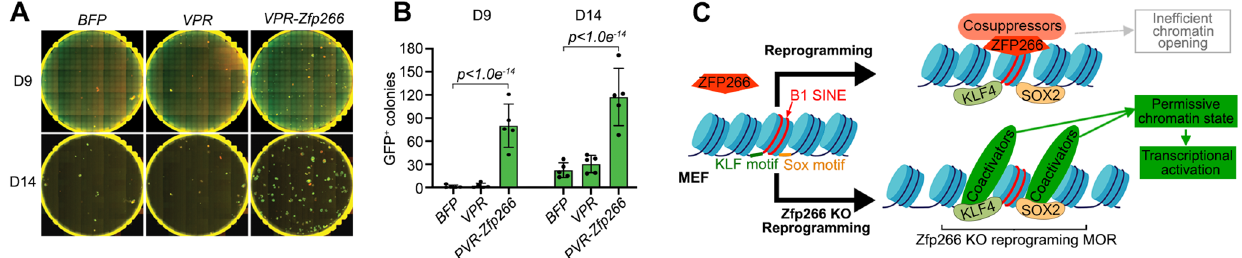
Fig. 7 | Chromatin accessibility at the ZFP266 target loci affects reprogram- ming ef fi ciency. A Day 9 and day 14 after OSKM induction with overexpression of either BFP, VPR only or VPR-Zfp266 . Red; mOrange, Green; Nanog -GFP. B Quanti fi cation of Nanog -GFP + colony numbers at day 9 and day 14. Data repre- sents an average of three independent experiments. Error bars indicate SEM. p -values calculated using a one-way ANOVA test. C Mechanistic model depicting how Zfp266 KO enhances reprogramming. Source data are provided as a Source